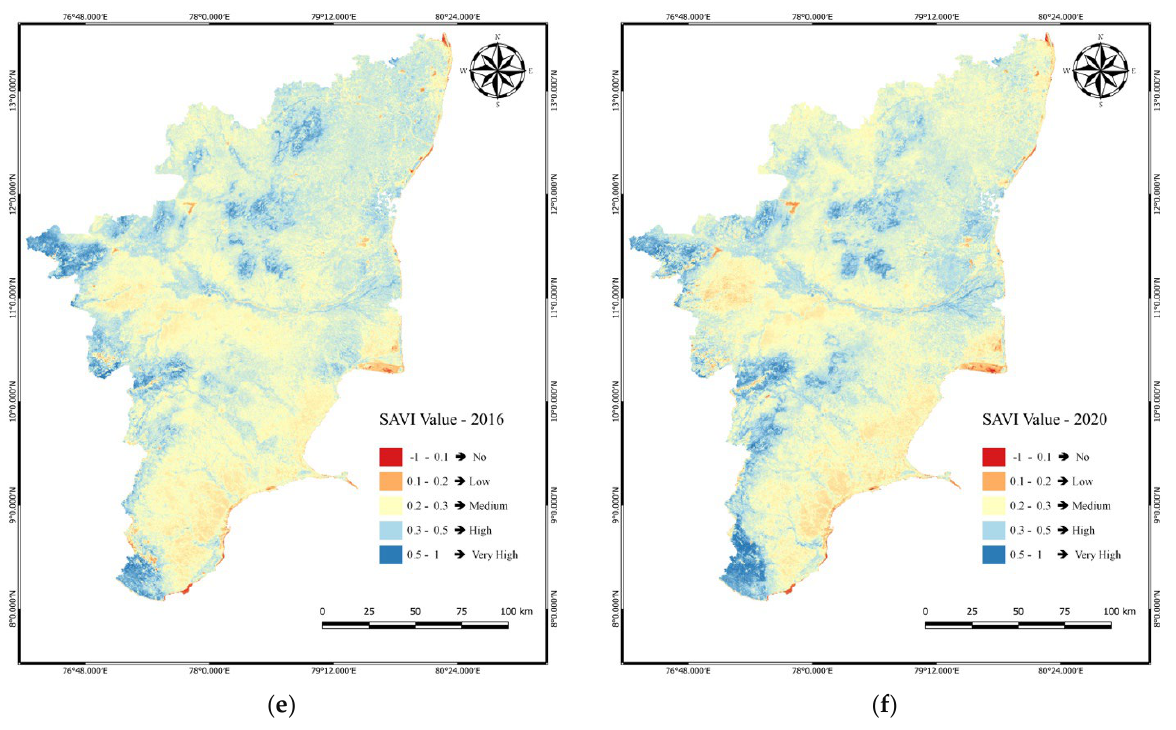
Figure 5. SAVI map for Tamil Nadu depicting the soil moisture related with permeability ( a ) 2000,